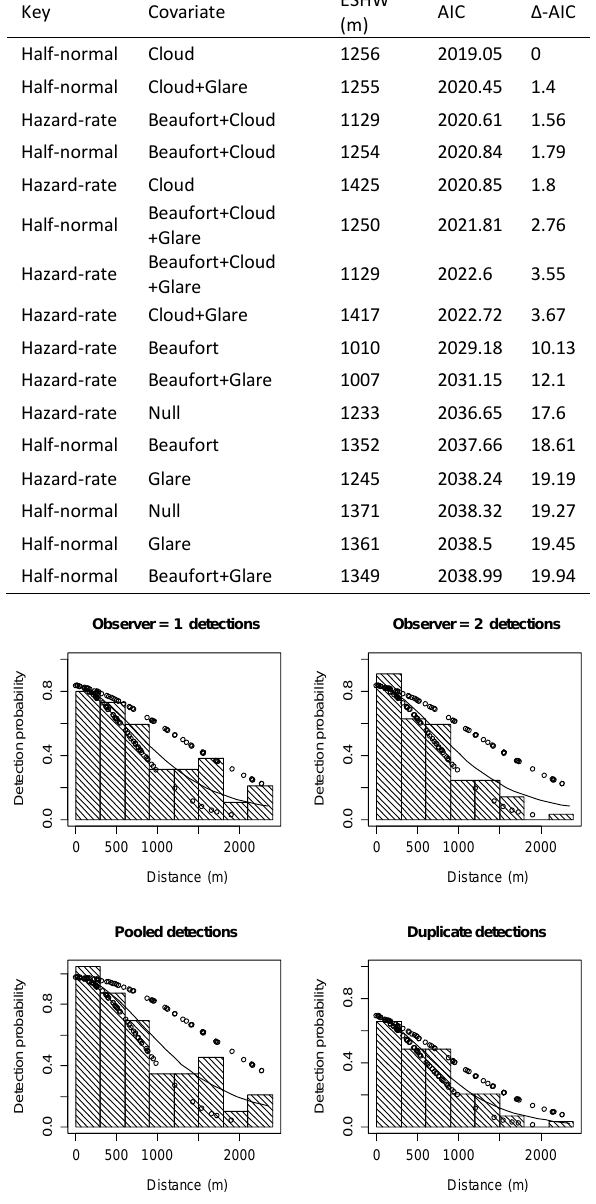
Figure 8. Mark-Recapture detection function plots assuming point independence between observers. Circles are the probability of detection for each sighting given its perpendicular distance and covariate value “cloud cover”. Lines are the fitted models . Fjord strata All fjords in Admiralty Inlet and Eclipse Sound were surveyed. In